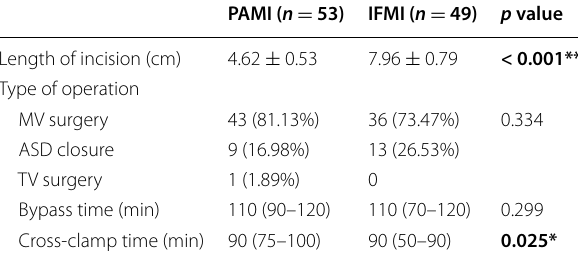
PAMI periareolar minimally invasive, IFMI inframammary minimally invasive, ASD atrial septal defect, MV mitral valve, TV tricuspid valve